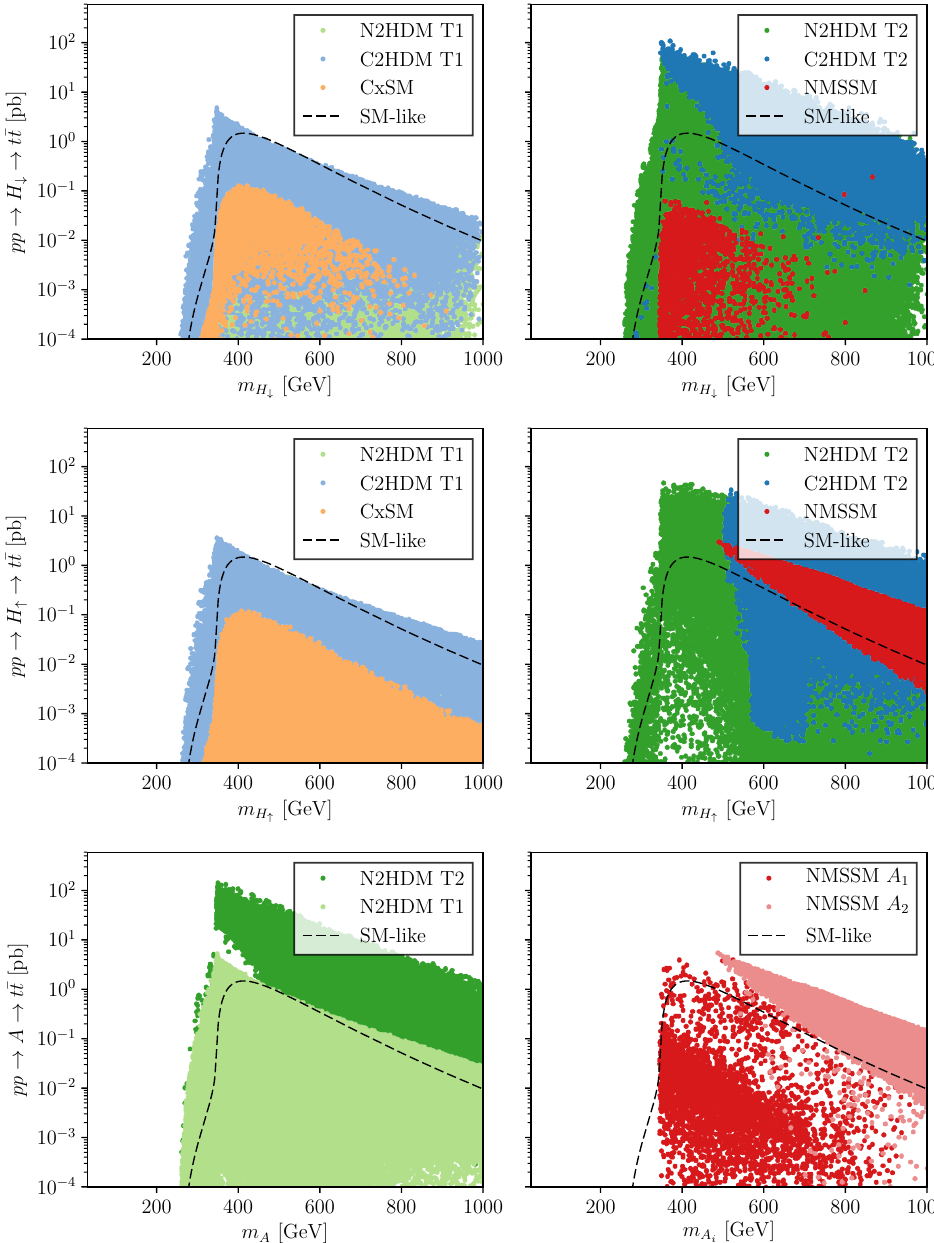
Figure 11 . Same as (cid:12)gure 9 but for the top-quark pair (cid:12)nal